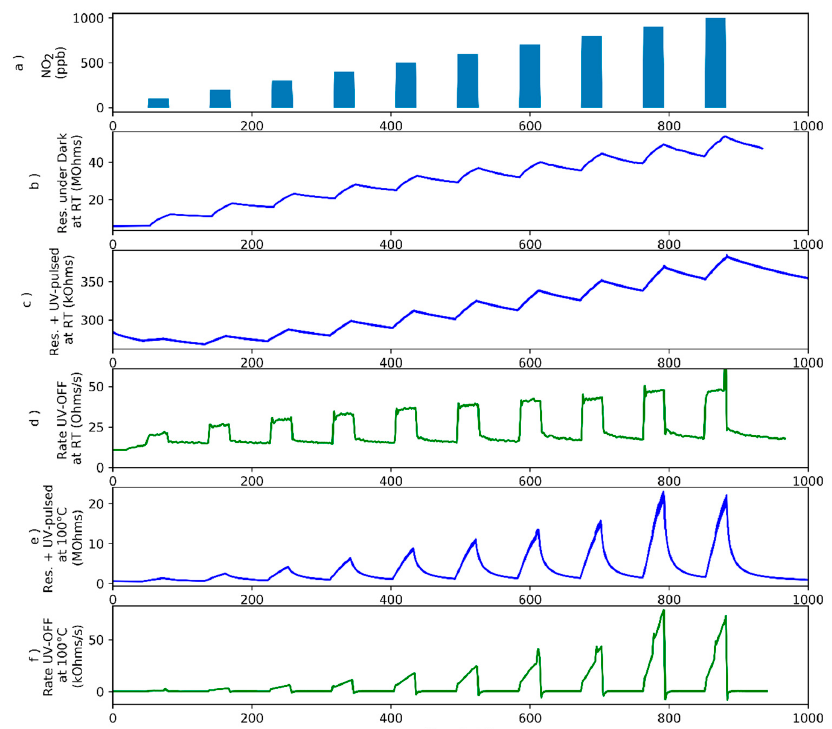
Figure 5. The sensor has been tested for several NO 2 concentrations ( a ). Evolution of sensor resistance under dark conditions in response to successively increasing NO 2 concentration pulses while the sensor is operated at room temperature ( b ). Evolution of sensor resistance under pulsed UV light in response to successively increasing NO 2 concentration pulses while the sensor is operated at room temperature ( c ). Rate of resistance change evaluated when UV light is OFF as defined in Equation (1) while the sensor is operated at room temperature ( d ). Evolution of sensor resistance under pulsed UV light in response to successively increasing NO 2 concentration pulses while the sensor is operated at 100 °C ( e ). Rate of resistance change evaluated when UV light is OFF as defined in Equation (1) while the sensor is operated at 100 °C ( f ).